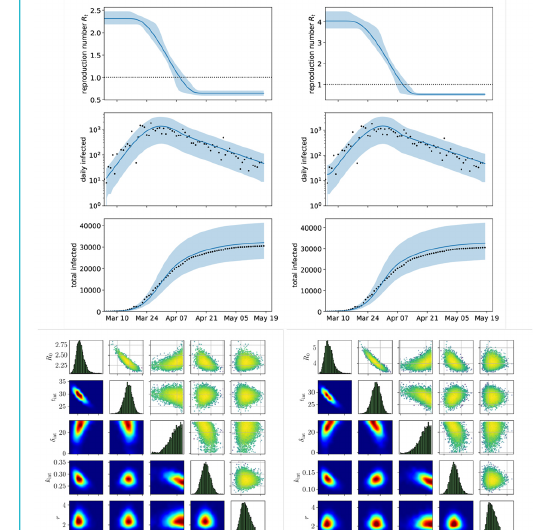
Figure 7: Inferred mean time of the start of interventions t int − ½ δ int (circles) with 90% confidence intervals (gray shades) com- pared with the offcial beginning (vertical bars) of non-pharmaceuti- cal interventions [15] in each country. Empty circles indicate miss- ing data for the offcial time. The countries are ordered by the inferred intervention time such that countries with similar parame- ters are located closer.